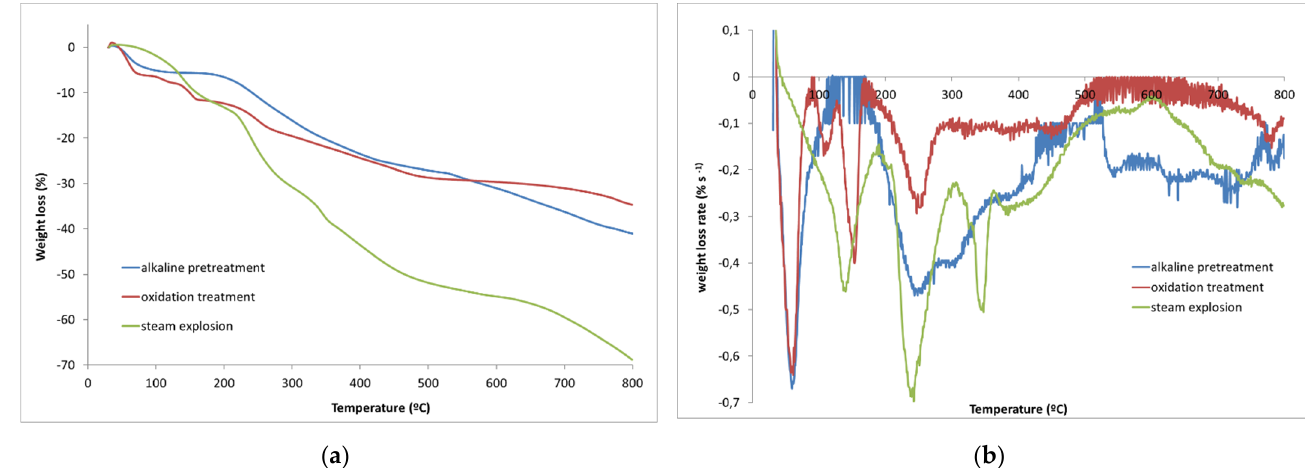
Figure 10. Thermograms of dried waste solutions generated after alkaline pre-treatment, hydrogen peroxide treatment and steam-explosion ( a ) TGA; ( b ) DTA.